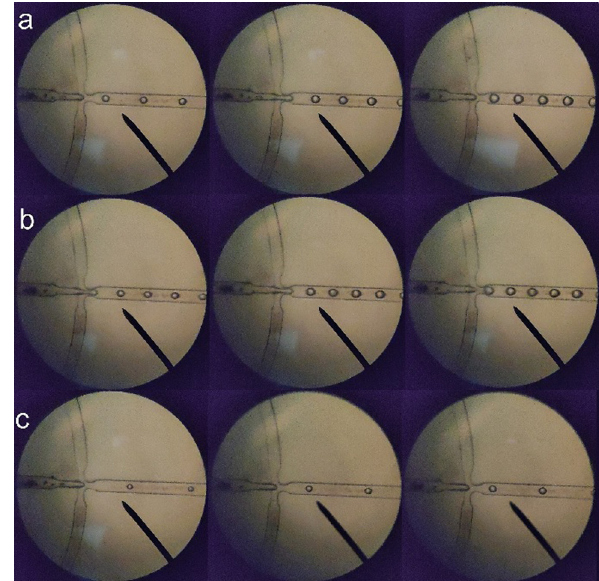
Figure 5: Illustrationoftheexperimentalresultsofthemicrogeldroplet. The velocity of the CS/MNPs - OA composite is fi xed at 3.3mm/s and the vegetable oil velocity is selected 11.1, 5.6, and 1.4mm/s for 0.2% CS and 0.5%, CS 2.8mm/s for 1.0% CS. ( a ) 0.2% CS with 0.5% MNPs - OA. (